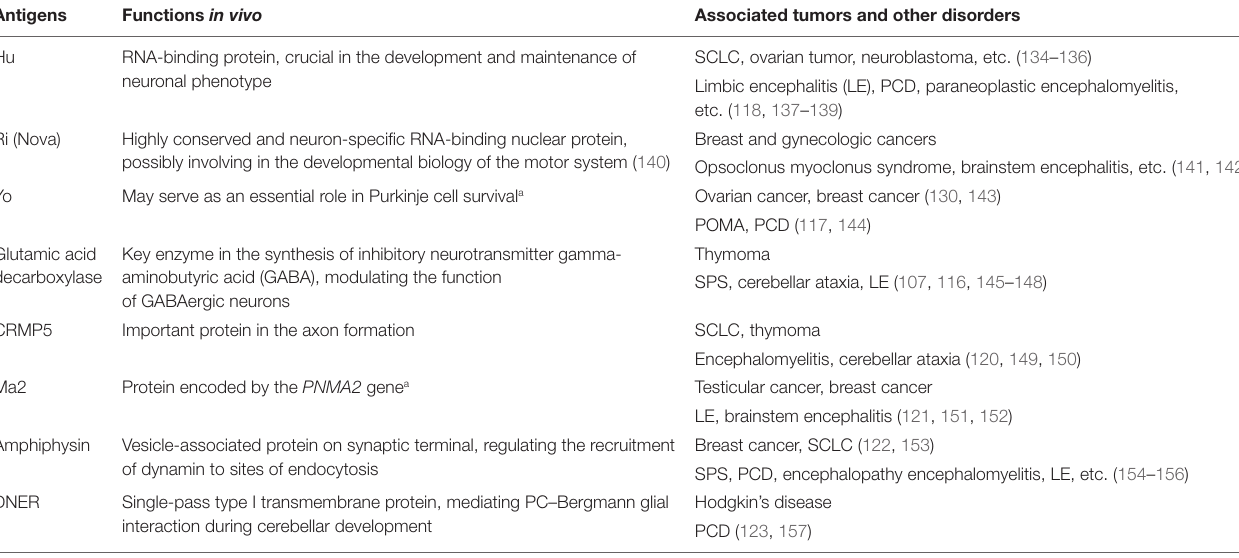
TABLe 1 | intracellular antigens found in autoimmune epilepsy (Ae) diseases.